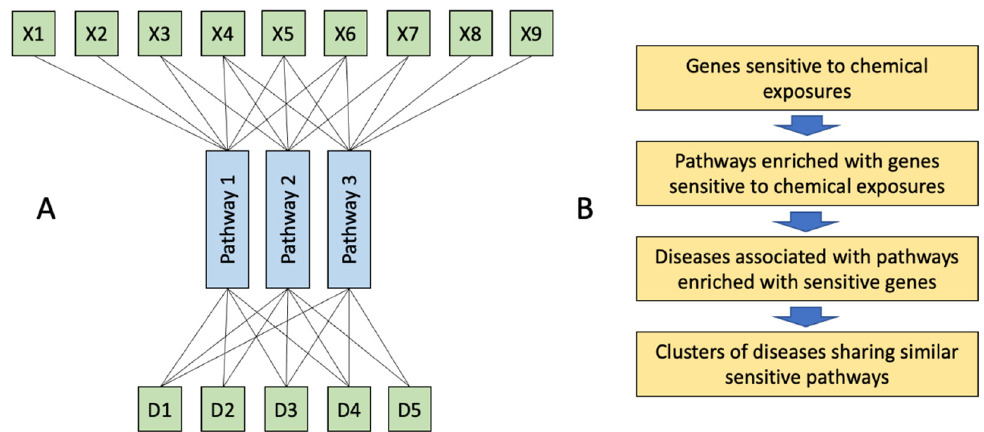
Figure 1. The whole person approach in toxicology. ( A ), Multiple xenobiotics (X) affect limited number of molecular pathways. Disruption of these pathways in different cells across the organisms may result in the development of seemingly unrelated diseases (D) which represent a syndrome of chemical exposure. ( B ), Outline of this study: genes sensitive to chemical exposures, identified by overlaying transcriptomic datasets from toxicological studies were used to identify pathways sensitive to chemical exposures. These pathways were further used to identify associated diseases. Finally, clusters of diseases sharing similar pathways were identified to predict syndromes of chemical exposures.